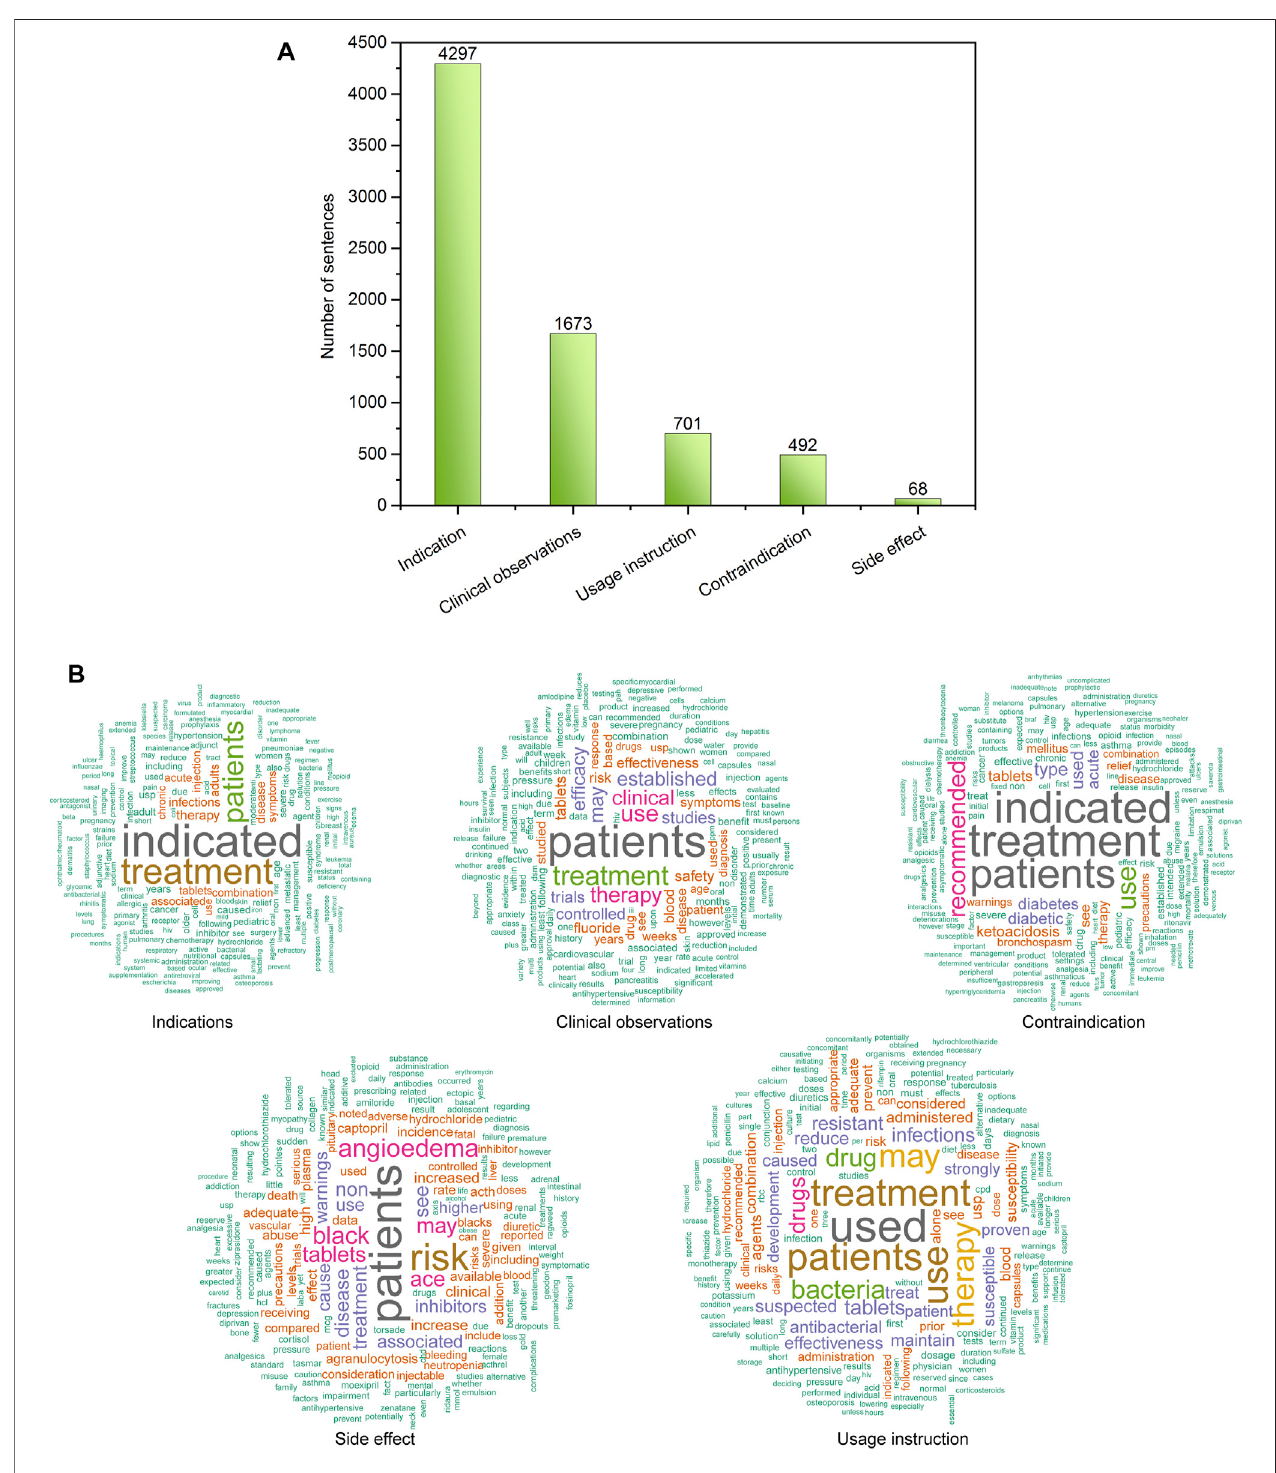
FIGURE 2 | (A) Distribution of sentences in the proposed DICE scheme; (B) word cloud of the sentences in each de fi ned DICE category.